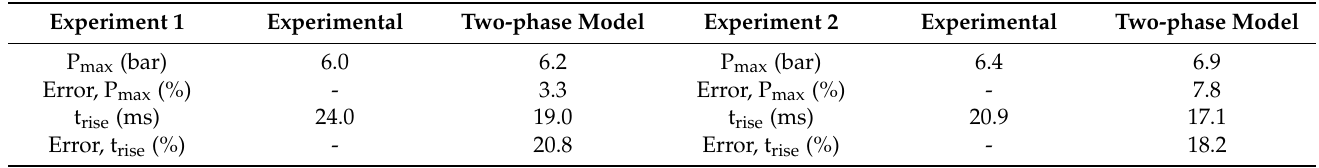
Figure 2. Wall pressure evolution as a function of time. Comparison of numerical and experimental results for Experiment 1 (C-EXP1) ( up ) and Experiment 2 (C-EXP2) ( down ). “Wall pressure” represents relative pressure with respect to the atmospheric pressure. Table 3. Comparison of the two-phase model prediction with experimental data. Prediction of the peak pressure and time of pressure